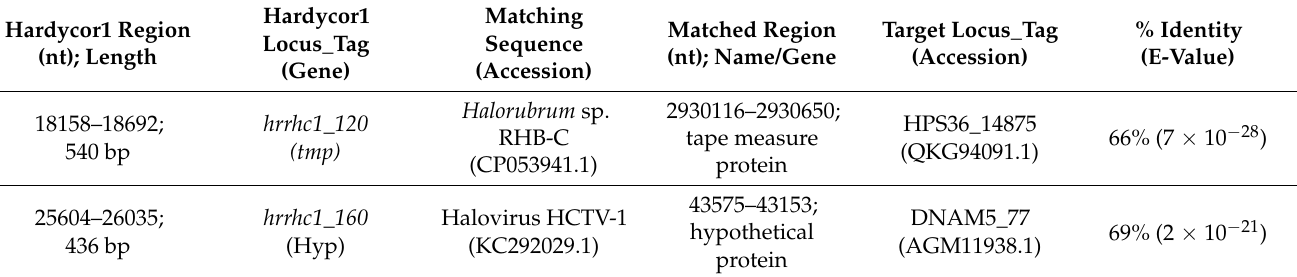
Table 4. BLASTn matches to the Hardycor1 genome a .